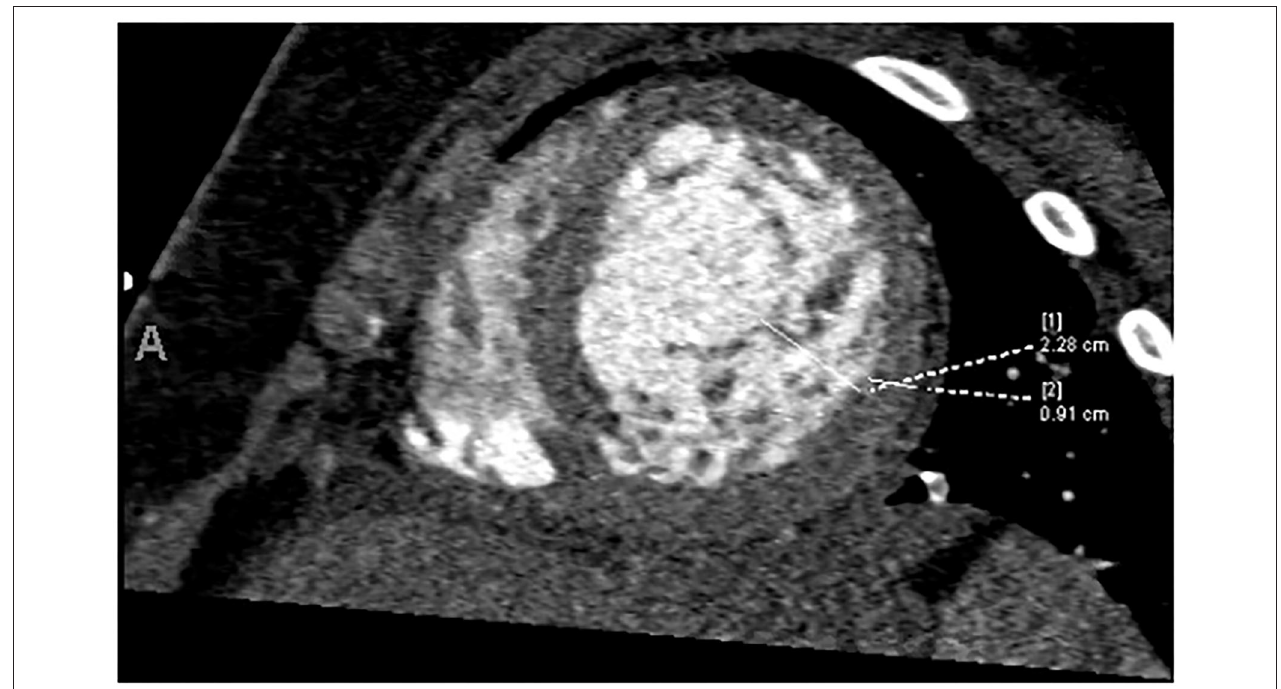
FIGURE 3 | Increased trabeculation in the left ventricle, particularly in the midsections and apex with a non-compacted to compacted ratio of 2.5.